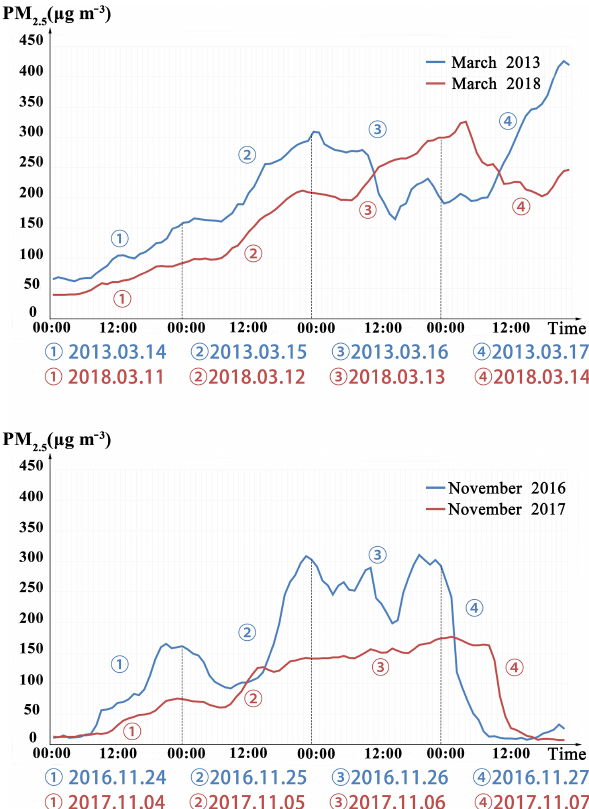
Figure 2. Variations in PM 2 . 5 concentrations during four pollution episodes with different emission-reduction measures in